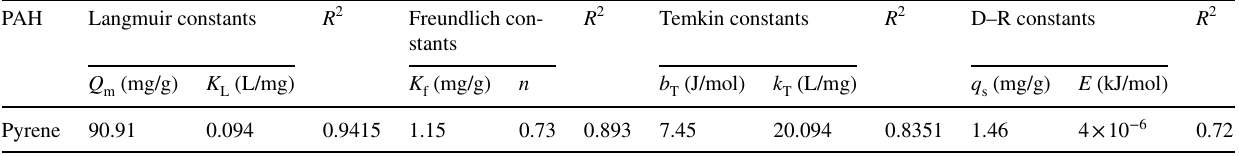
Table 4 Isotherm parameters with coefficient of determination ( R 2 ) for the adsorption of pyrene over CP-1 at 25 ± 2 °C R 2 Temkin constants R 2 D–R constants R 2 PAH Langmuir constants R 2 Freundlich con- stants Q K K n m (mg/g) L (L/mg) f (mg/g) Pyrene